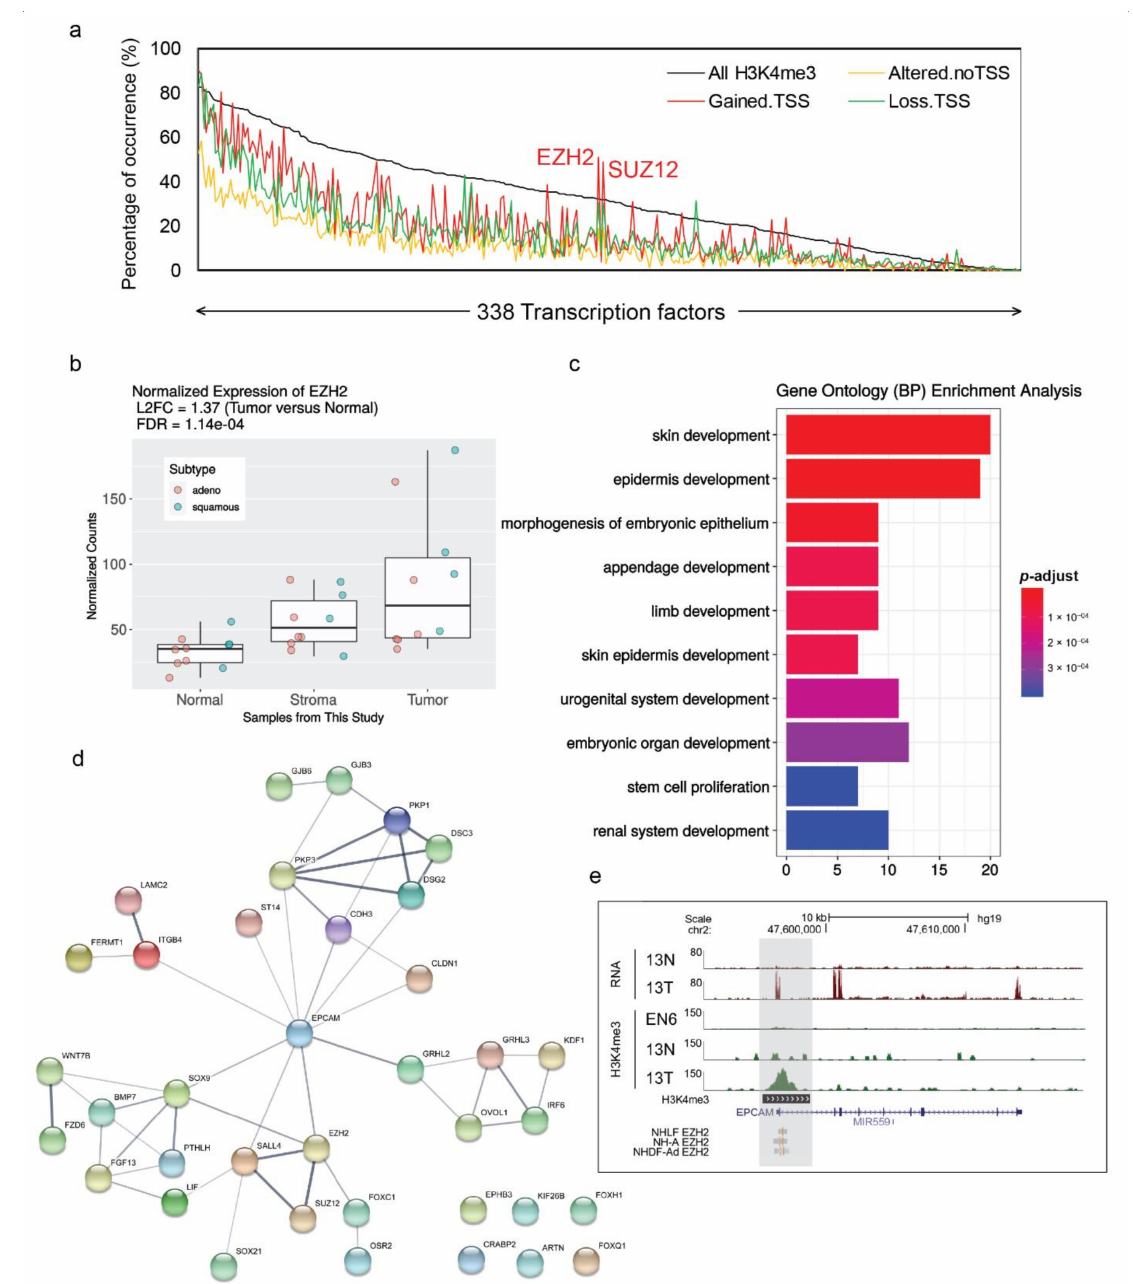
Figure 4. ( a ) Binding enrichment of ReMap-defined transcription factor binding sites at genomic regions exhibit H3K4me3 signals. Transcription factors were sorted according to their percentage of occurrences at all H3K4me3 regions. Proximal tumor-gained promoters (gained.TSS) significantly enriched with EZH2 and SUZ12 binding sites ( p -value < 0.01, one-tailed Fisher’s exact test). The complete TF list is presented in Table S14. ( b ) Boxplot of the median expression levels for EZH2 in this study’s normal samples ( n = 10), stroma samples ( n = 10), and tumor samples ( n = 10). Individual values are presented as colored circles. Red circles indicate LUAD subtypes, light green circles indicate LUSC subtypes. Log2-fold change (L2FC) and false-discovery rate (FDR) were calculated between tumor and normal samples. ( c ) Gene ontology (GO) terms for biological process (BP) enrichment analysis and ( d ) protein–protein interaction analysis from STRING of all the nearby genes of tumor-gained promoters exhibiting EZH2 and SUZ12 binding sites. ( e ) A capture of the UCSC genome illustrates the tumor-gained H3K4me3 signals (grey shaded boxes) at the TSS of the EPCAM gene, which exhibits the binding sites of EZH2 transcription factors. In this capture, samples from case 13 (normal, N; tumor, T) and ENCODE normal sample EN6 were